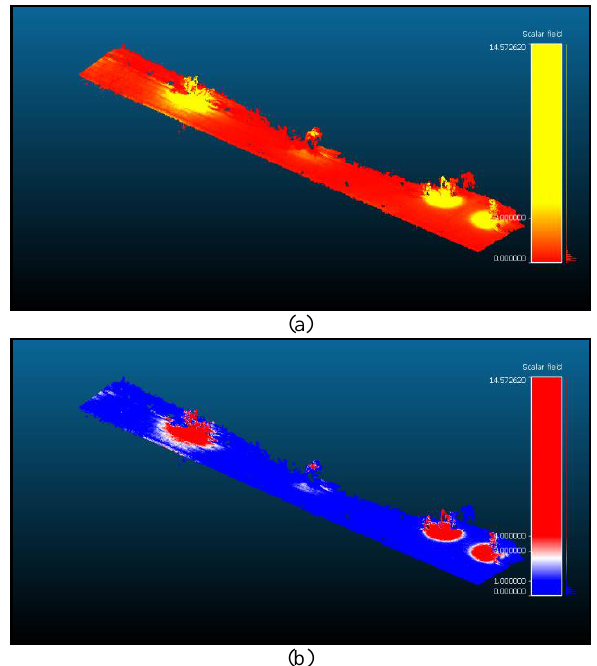
Figure 16. Illuminance data integrated 3D model (a) having an interval of less than and greater than 3 (b) having an interval of less than 1, 1-4, and greater than 4. The color bar indicates the luminance values in lux.